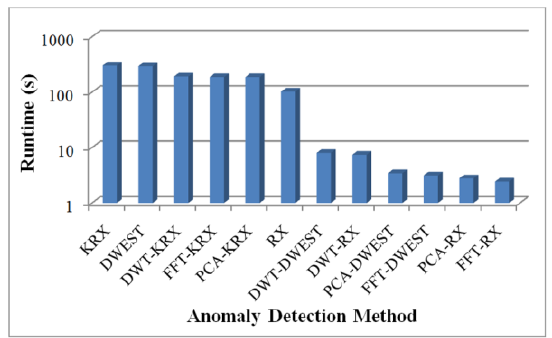
Figure 13. Runtime comparison of various anomaly detectors applied to